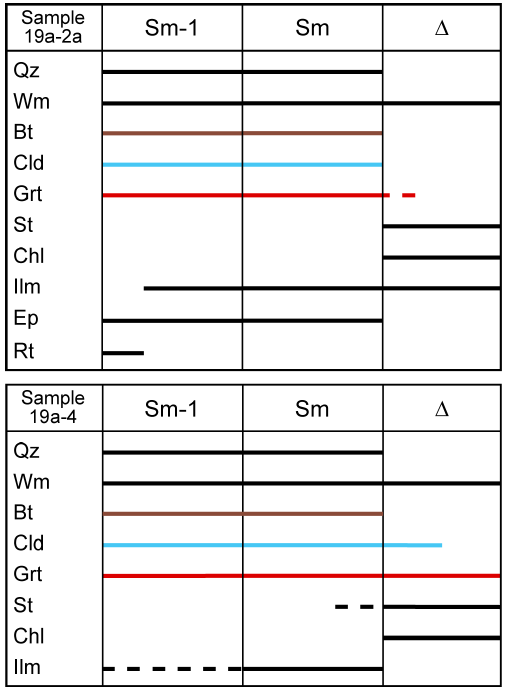
Figure 4. Blastesis–deformation relationships for the two studied samples. Biotite, chloritoid and garnet have been highlighted with brown, light blue and red lines, respectively, to emphasize their in- ferred equilibrium relations. (cid:49) refers to a static episode of blastesis, opposite to the two episodes of blastesis related to the development of Sm and Sm − 1.